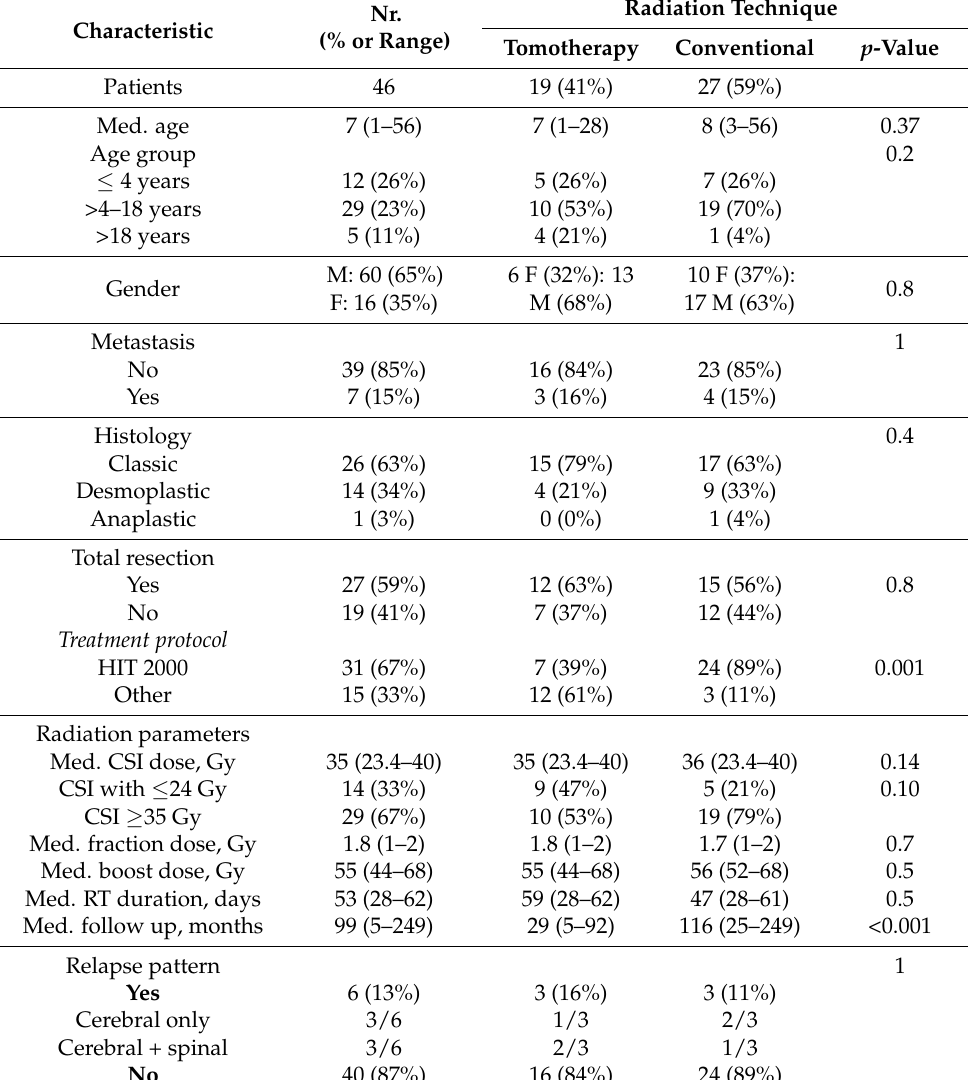
Table 1. Patient and treatment